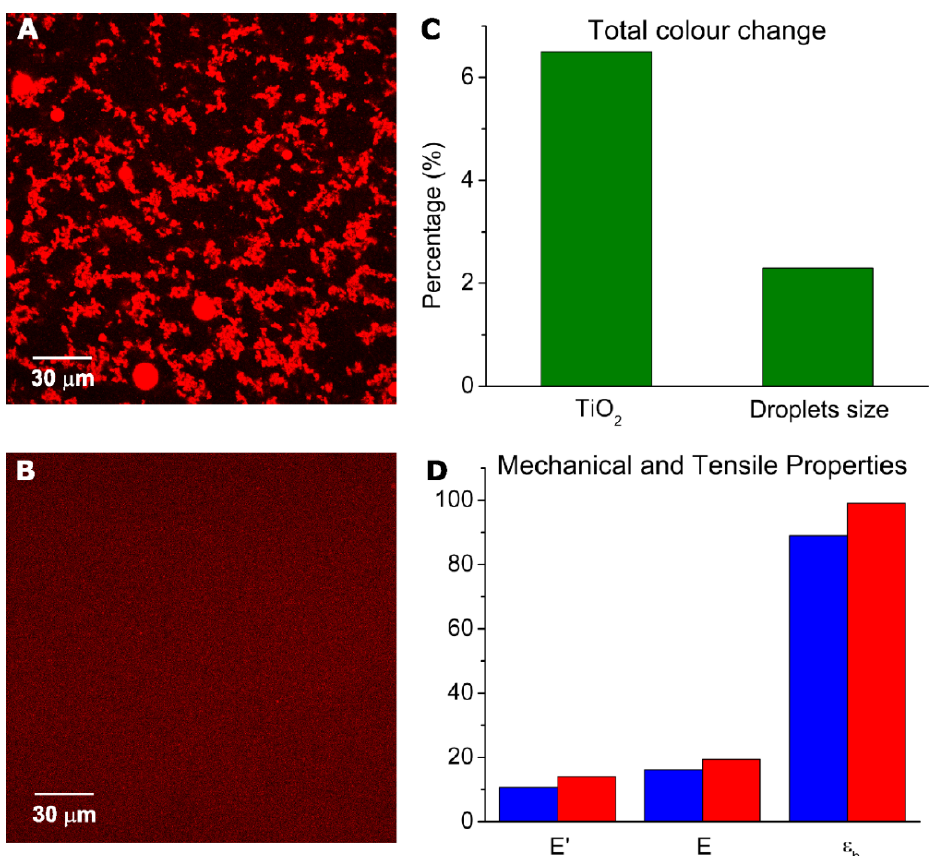
Figure 5. Microstructure of starting systems (left column) and physical properties of the obtained films (right column). Laser scanning confocal microscopy images of emulsions used to prepare films: ( A ) conventional emulsion; ( B ) nanoemulsion. Physical properties: ( C ) total color change due to addition of TiO 2 or to changes in droplets size (conventional to nano); ( D ) storage modulus (E’), Young modulus (E), and elongation at break ( ε b ). Blue: film from conventional emulsion; red: film from nanoemulsion (reprinted from ref.